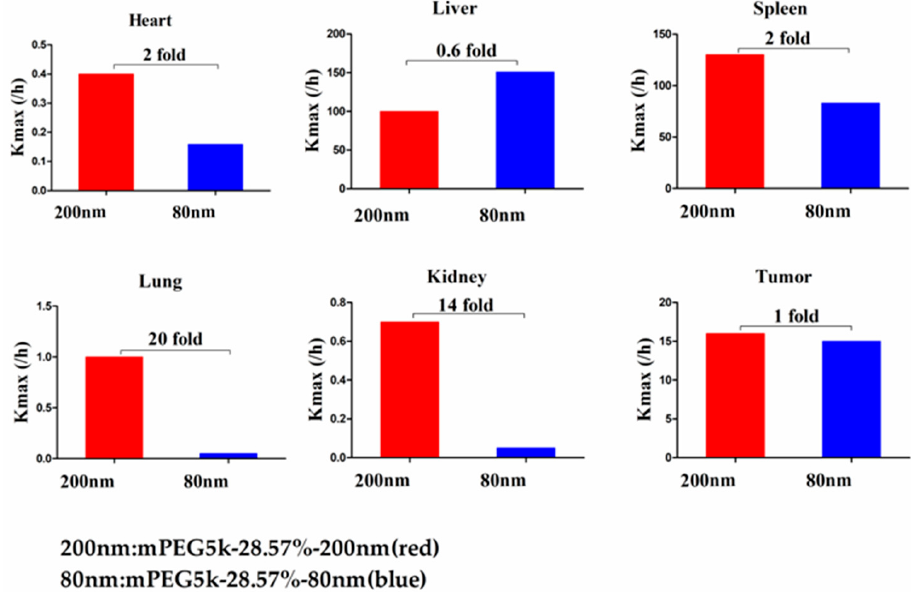
Figure 13. K max (/h) for mPEG5k-28.57%-200 nm (red) and mPEG5k-28.57%-80 nm NPs (blue).